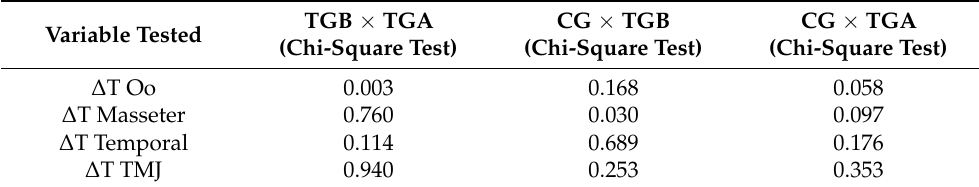
Table 4. Chi-square analysis comparing the health status of the ROI (healthy/abnormal) be- tween